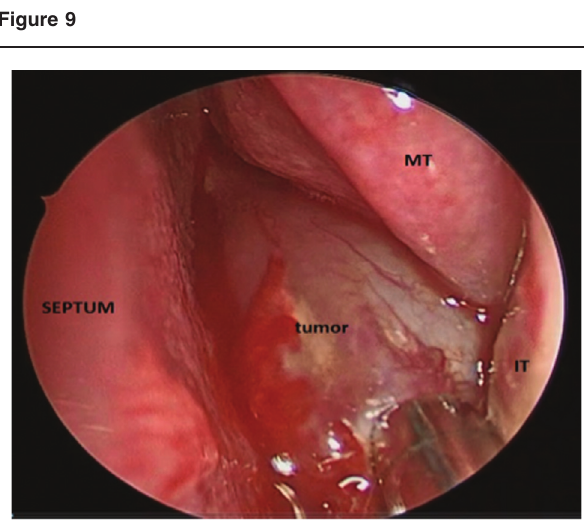
The tumor of 10cm in length.